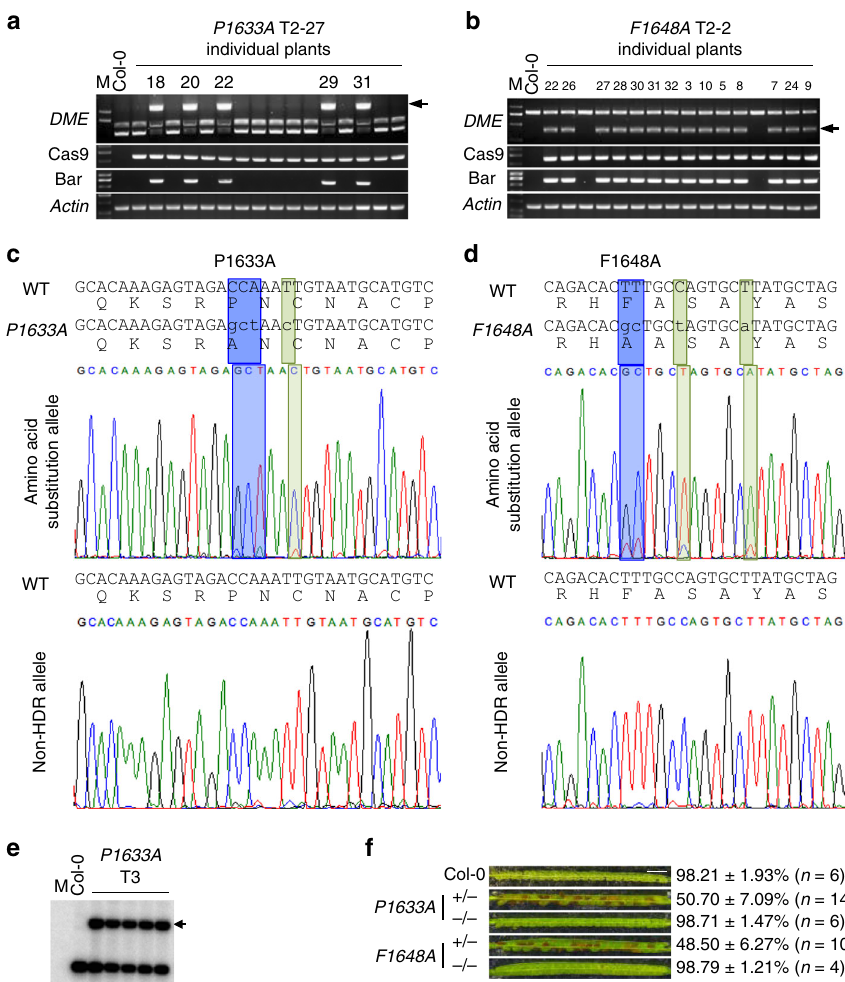
Fig. 4 Single amino acid substitution at the endogenous DME locus by gene targeting. a , b Genotyping of T2 individual plants for P1633A and F1648A , respectively. Arrows indicate the speci fi c sequence substitution as detected by PCR and restriction enzyme digestion. PCR primers are as depicted in Supplementary Figure 6a and Supplementary Table 4. Detailed information is described in Supplementary Figure 6. c , d Sequence con fi rmation of the P1633A and F1648A substitutions, respectively, in individual T2 plants. Blue highlights indicate amino acid substitution, green highlights indicate silent mutations. The sequence chromatograms are taken from FinchTV. e Southern blotting. The P1633A substitutions were con fi rmed by Southern blotting in heterozygous T3 plants. The arrow indicates the band caused by speci fi c base substitution. f Analysis of seed abortion. Seeds from Col-0, heterozygous GT ( + / − ), and non-GT ( − / − ) P1633A and F1648A T3 plants were analyzed. Scale bar, 1 mm